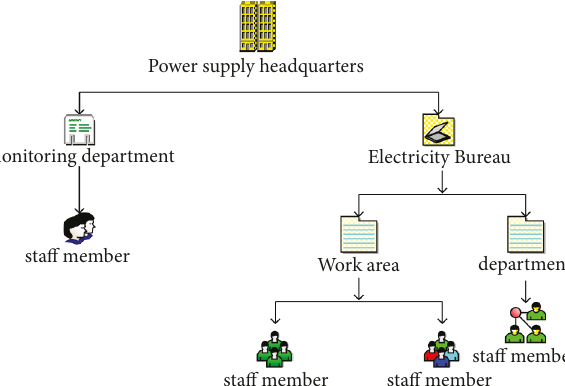
Figure 3: User organization structure.